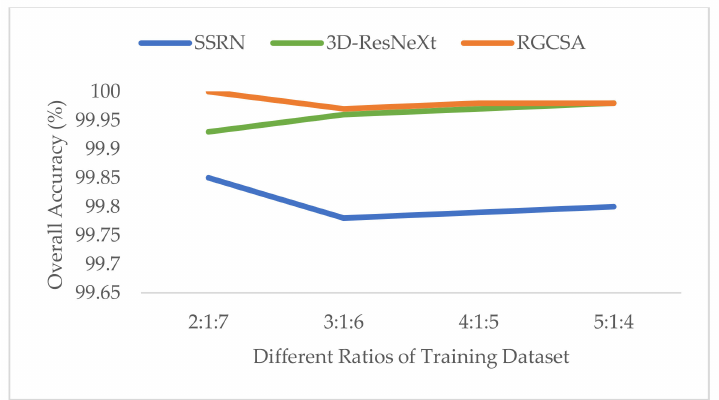
Figure 14. OAs of the SSRN, 3-D-ResNeXt, and RGCSA with di ff erent ratios of training samples for the IN dataset.